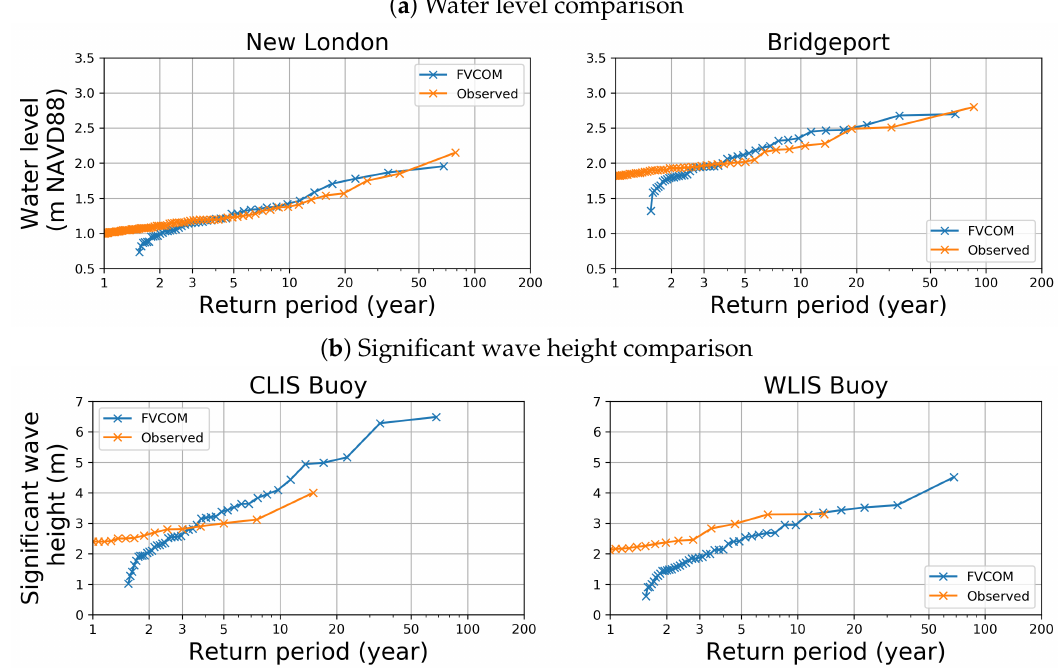
Figure 5. Return periods of observed and modeled water level ( a ) and significant wave height ( b ) at the location of